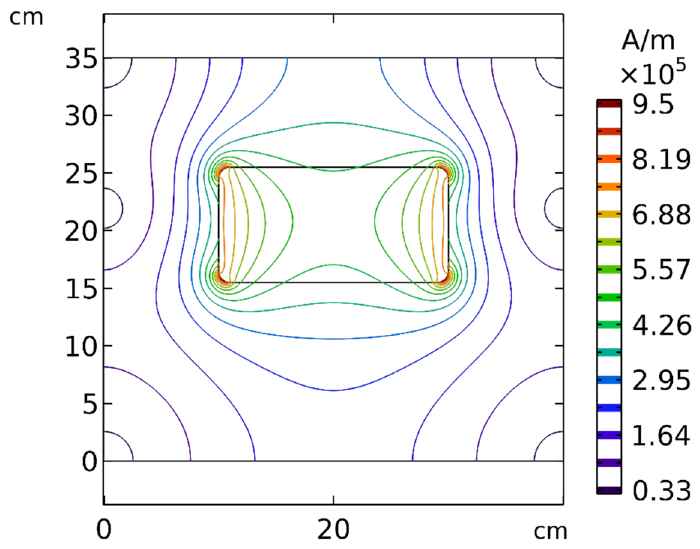
Figure 19. Contours of the magnetic field ( H ) around the permanent magnet and in the solution area.